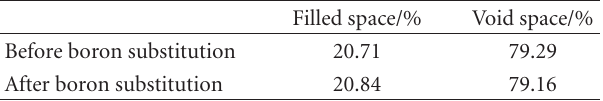
Table 4: Porosity of osteoporosis bone for boron